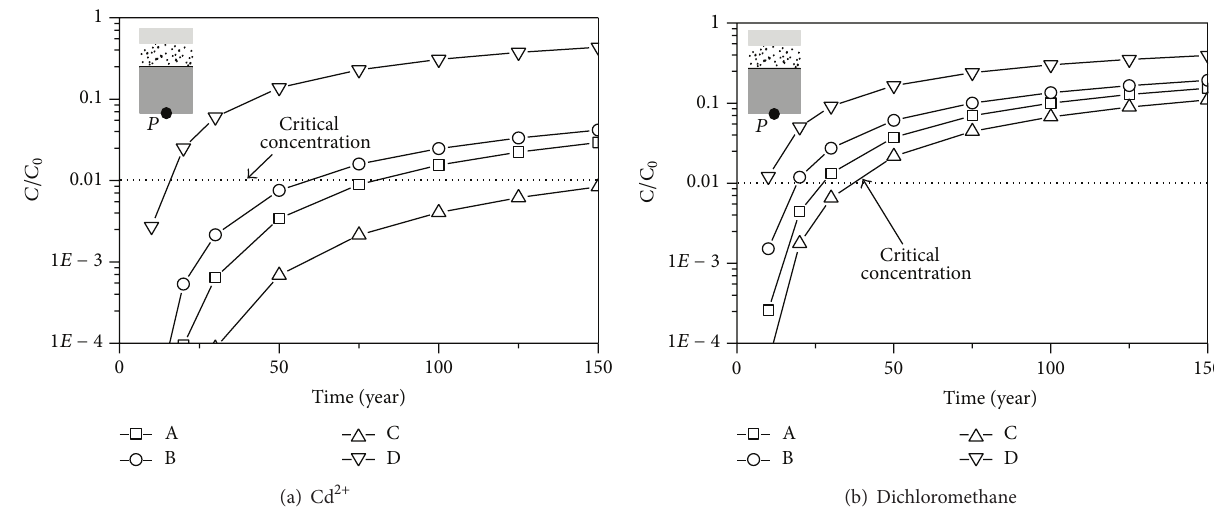
Figure 2: The concentration-time curves of the contaminants.